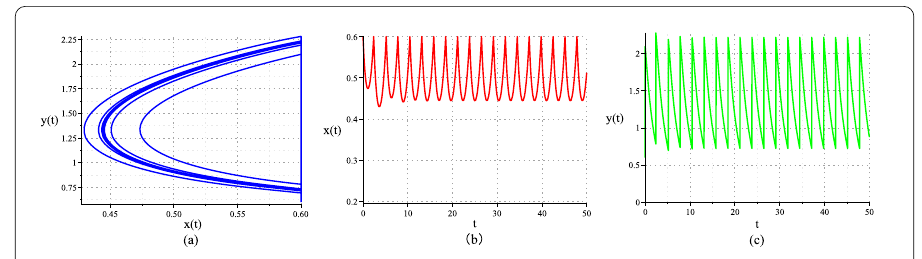
Figure 4 Numerical simulation of Example 1. (a) Phase portrait of x ( t ) and y ( t ) on h 1 = 0.6. (b) Time series of x ( t ). (c) Time series of y ( t